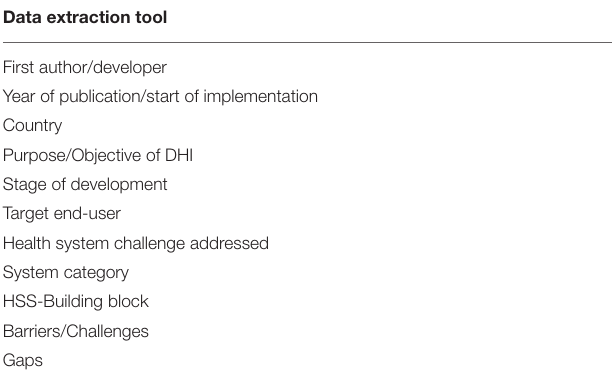
TABLE 3 | Evidence source documentation and extracted information relevant to the scoping review. Data extraction